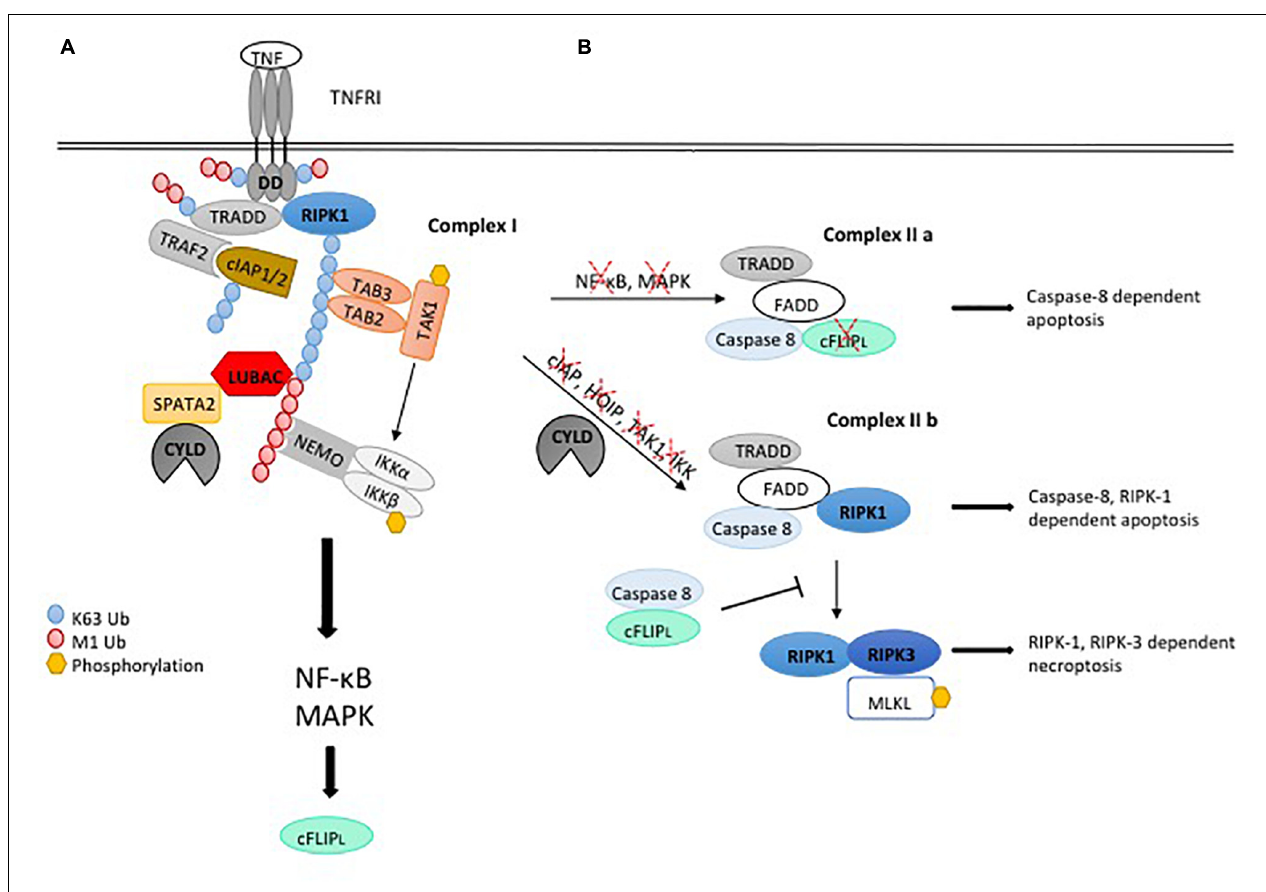
FIGURE 1 | Ubiquitylation regulating pro-inflammatory signaling and cell death induction by the TNFR1-SC. (A) Upon binding of TNF to TNFRI, complex I is assembled by binding of the adaptor protein TRADD and the kinase RIPK1 to the receptor. Recruitment of TRAF2 and the E3 ligase cIAP1/2 leads to K63-linked ubiquitylation within the complex, serving as a platform for binding of TAB2/3 and TAK1 to mediate activation of MAPK signaling. In addition, K63-linked poly-ubiquitin chains recruit LUBAC, which mediates M1-linked ubiquitylation of different components within the complex, promoting association of NEMO and activation of IKKa α / β and NF- κ B. Assembly of the TNFR1-SC is negatively regulated by the DUB CYLD, which interacts with the LUBAC component HOIP via the bridging protein SPATA2 and is recruited to the TNFR1-SC, thereby diminishing M1- and K63-linked ubiquitin chains. (B) TNFR1 stimulation induces functional variants of the cell death promoting complex II, consisting of the adaptor TRADD and FADD, RIPK1, caspase-8 and its paralog c-FLIP. Abrogation of NF- κ B induced gene expression permits caspase-8 activation in complex II a, leading to cell death by apoptosis. When ubiquitylation of the TNFR1-SC is compromised, caspase-8-activating complex II b is formed, which induces apoptosis depending on RIPK1 kinase activity. Upon loss of caspase activity, RIPK1 associates with RIPK3, which phosphorylates and activates MLKL, leading to necroptotic cell